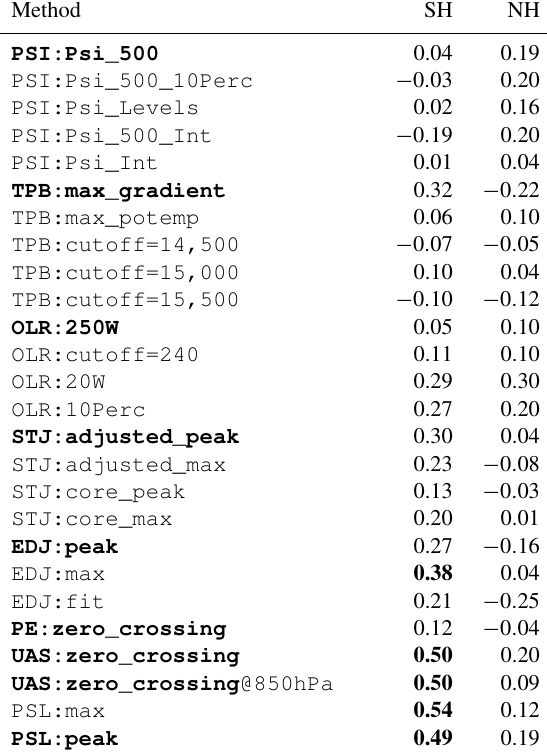
Table 2. The Pearson coefficient of inter-model correlation between the interannual variability (defined as the standard deviation of annual-mean values for 1979–2004) of the metric and the latitudinal spacing of the model output in the 34 CMIP5 models. Default meth- ods and statistically significant correlations ( p < 0 . 05) are